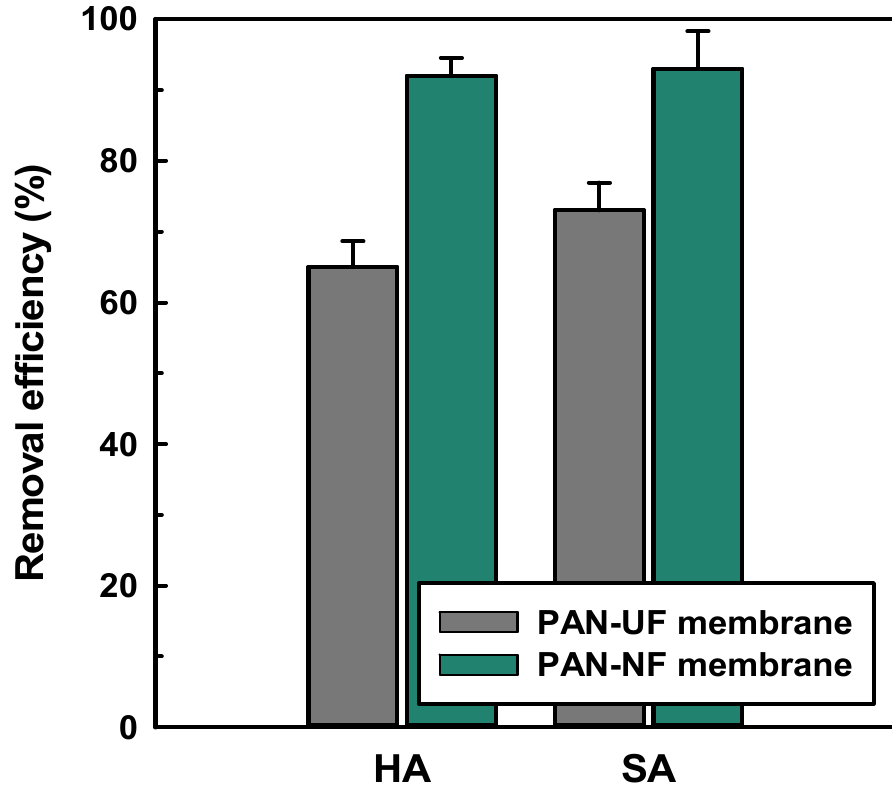
Figure 2. Removal of natural organic matter (NOM) (humic acid, HA, and sodium alginate, SA) by pristine and modified PAN-NF HF membranes. Operating conditions: HA and SA = 5 mg/L; pressure = 5 bar; stirring speed = 300 rpm; cross-flow velocity = 1 L/min; conductivity = 300 μ s/cm; and temperature = 25 °C.